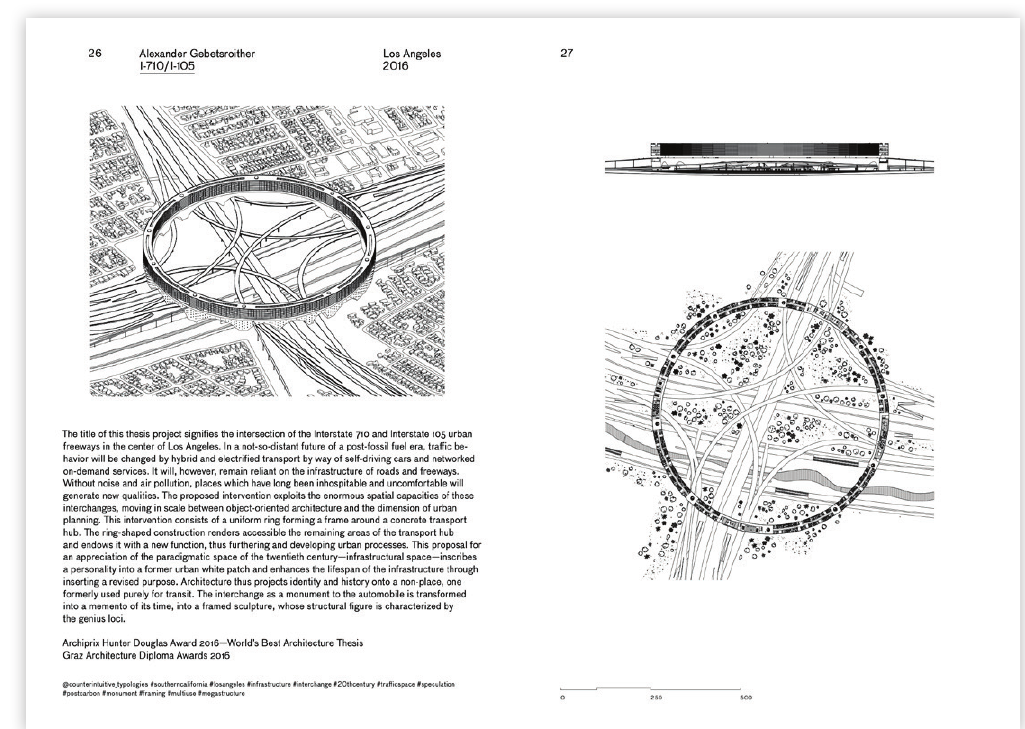
Figure 5. Page spread from Masters Th eses booklet in Th inking Design